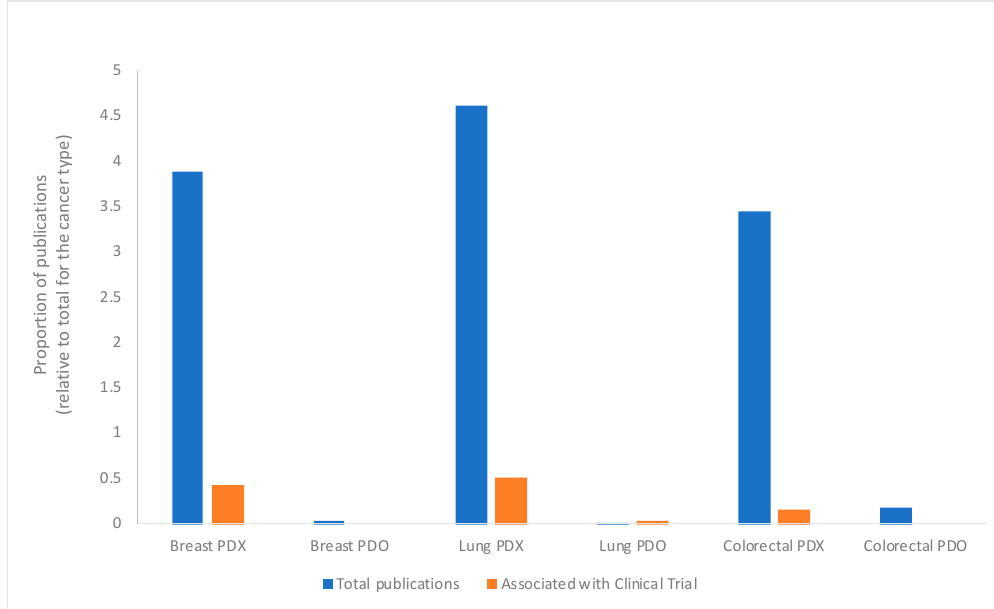
Figure 2. Publications employing patient-derived xenograft (PDX) or patient-derived organoids (PDO) for each cancer type, and their association with clinical trials. The proportion of papers published between 2014–2019 for breast, lung and colorectal cancers using PDX or PDO, relative to the total number of papers published for each cancer type, regardless of the technology used, and the papers associated with a clinical trial are shown. Blue bars indicate the proportion of papers using each technology, relative to the total number of papers for that specific cancer type, and orange bars indicate the proportion of papers associated with a clinical trial. Data were retrieved from PubMed as described in the